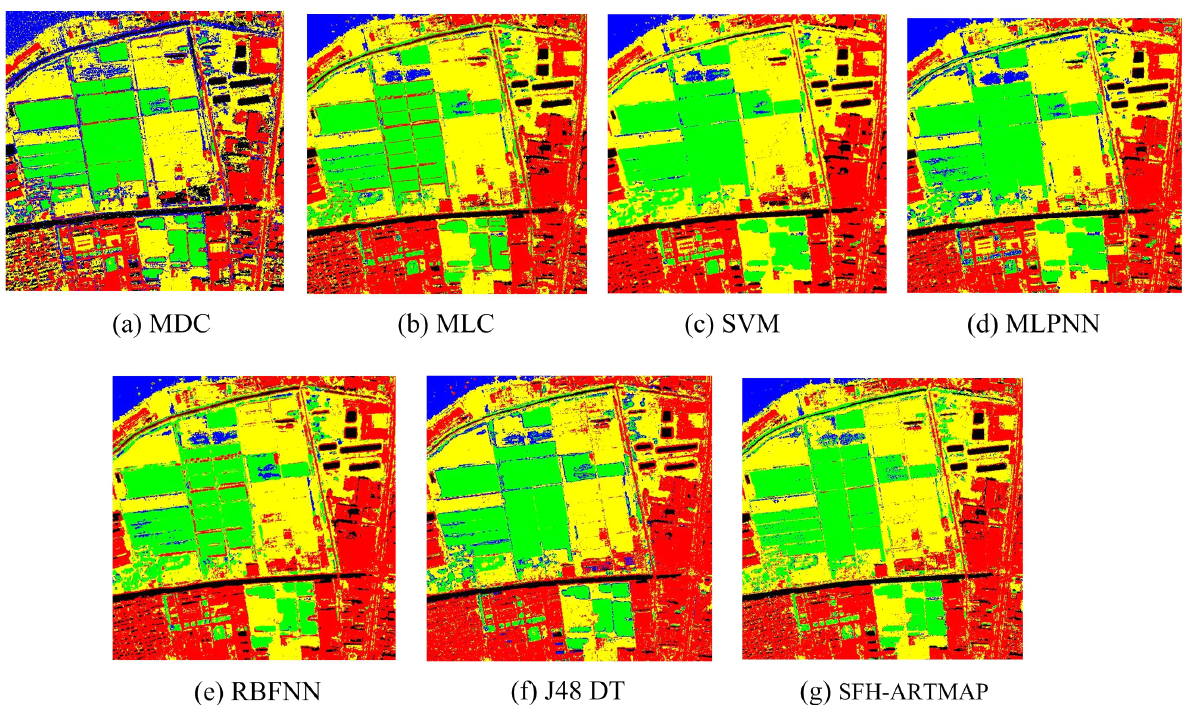
Figure 6. Classification results of using both spectral and textural